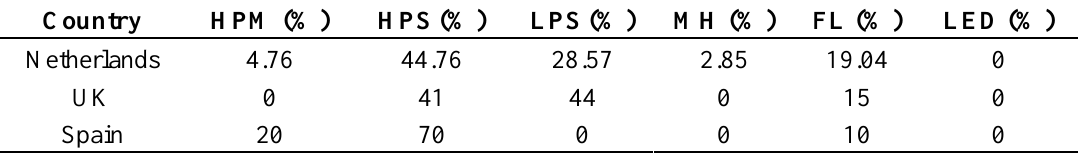
Table 1. Percentage of each kind of lamp in some European countries in 2007. Country HPM (%) HPS (%) LPS (%) MH (%) FL (%) LED (%) Netherlands 4.76 44.76 28.57 2.85 19.04 0 UK 0 41 44 0 15 0 Spain 20 70 0 0 10 0 HPM = high pressure mercury; HPS = high pressure sodium; LPS = low pressure sodium; MH = metal halide; FL = fluorescent; LED= light-emitting